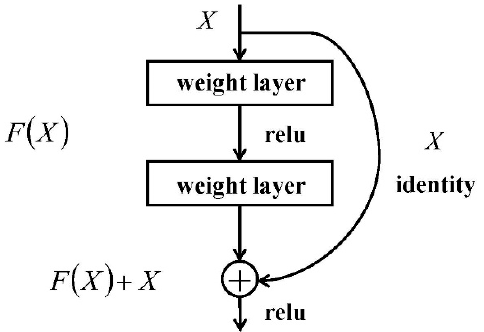
Figure 3. The architecture of a residual block